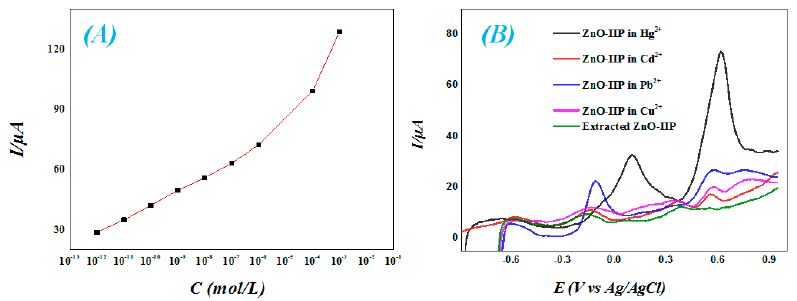
Figure 3 . ( A ): Follow up of pic currents variations (determined from SWV measurements) versus Hg 2+ concentration; ( B ): Selectivity tests: SWV curves of ZnO/Hg(II)-IIP electrodes incubated in 10 − 4 M solutions of either mercury, cadmium, lead or copper ions for 20